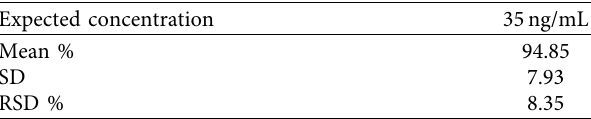
Table 6: Dilution integrity test of vardenafil in